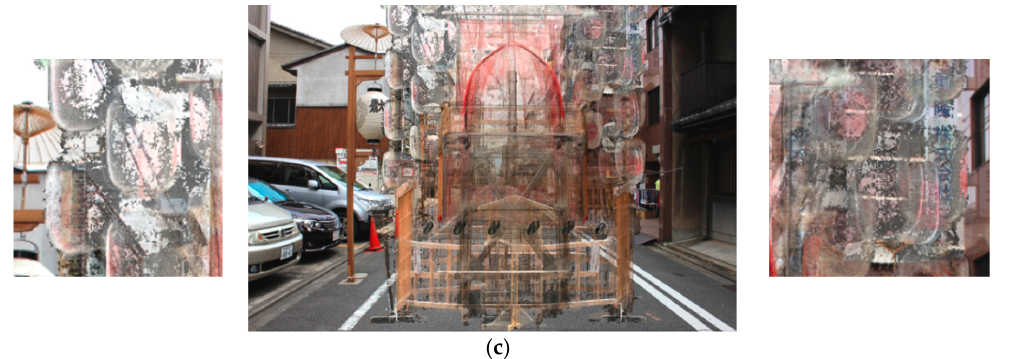
Figure 5. Visualization results of lightness adjustment with different β values: ( a ) 𝛽 = 0.9, ( b ) 𝛽 = 0.7, and ( c ) 𝛽 = 0.4 .